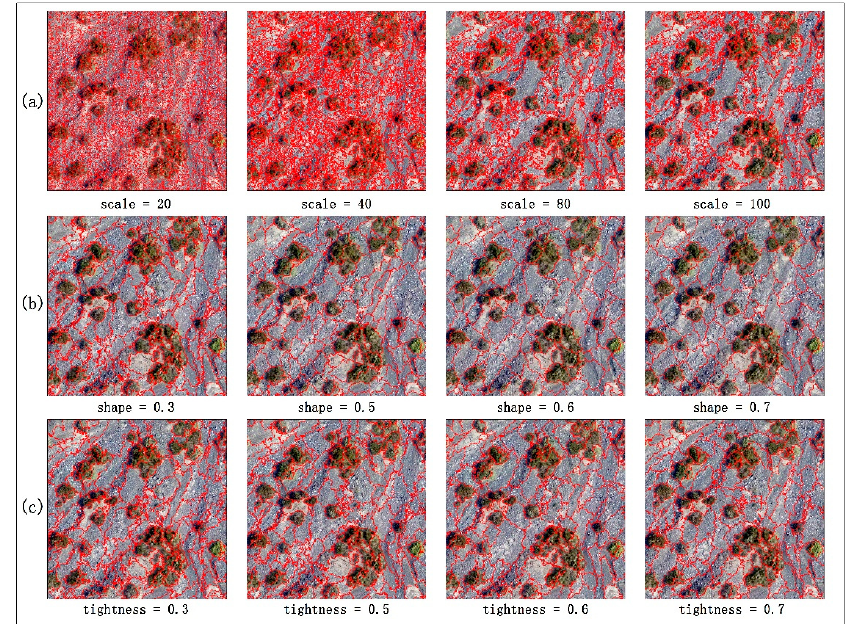
Figure 5. Example of the multi-scale segmentation results with various scale, shape, and tightness parameters. ( a ) Segmentation results of various scales (shape = 0.5, tightness = 0.5). ( b ) Segmentation results of various shapes (scale = 80, tightness = 0.5). ( c ) Segmentation results of various tightness parameters (scale = 80, shape = 0.3).